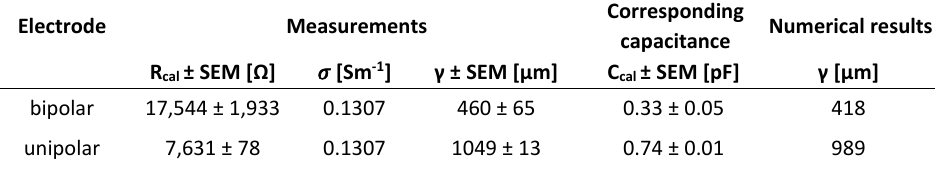
Table 2: Comparison of experimentally obtained parameters in calibration solution with numerical cell constants. The capacitances that correspond to R cal were calculated from the experimental cell constants with equation (2). Electrode Measurements